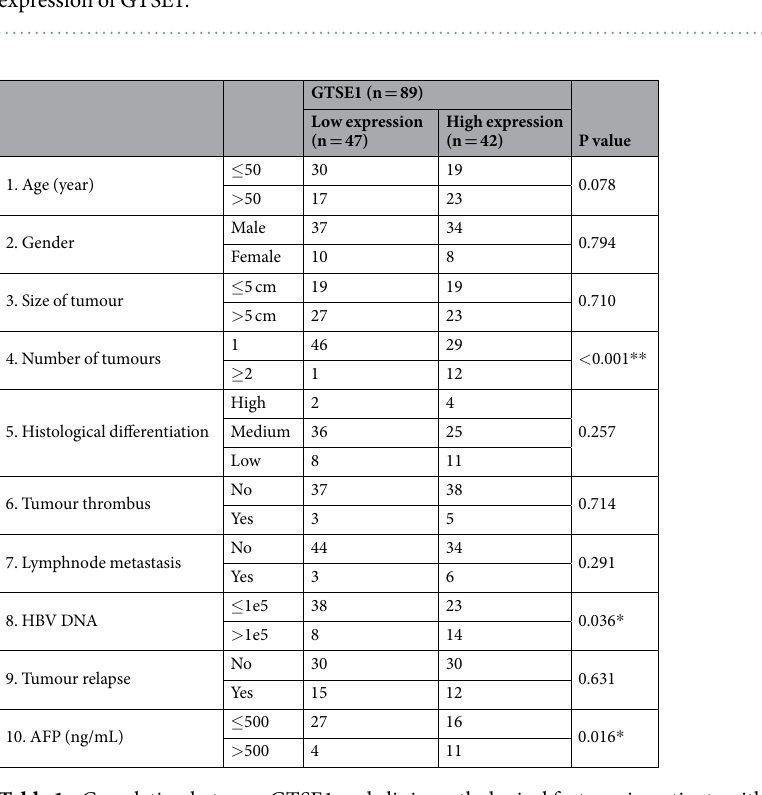
Table 1. Correlation between GTSE1 and clinicopathological features in patients with HCC. AFP, alpha- fetoprotein; * P < 0.05, ** P <